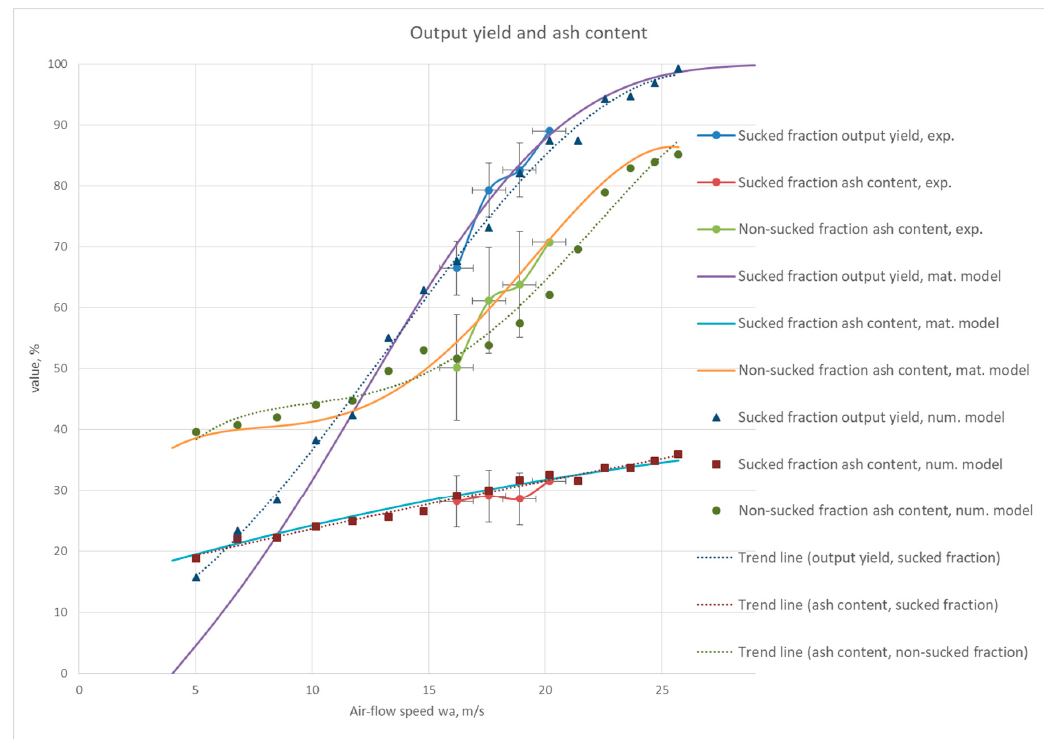
Figure A4. Comparison of values obtained experimentally and calculated using the developed models—output yield and ash content in relationship to air flow velocity; feed material no. 4 (0–20 mm).